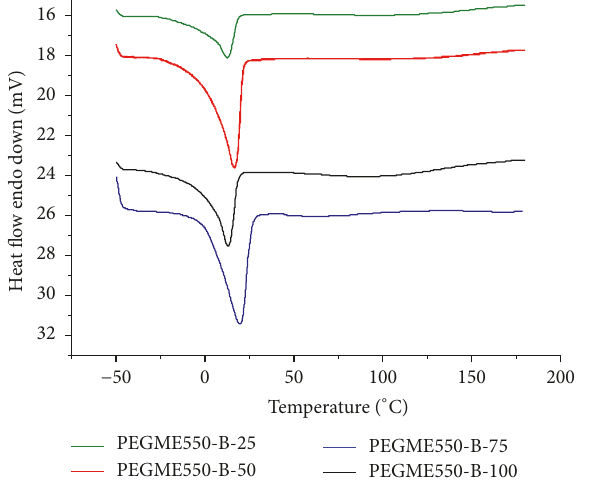
Figure 5: DSC curves of PEGME550-B- 𝑌 ( 𝑌 = 25, 50, 75, and 100) polymer electrolytes. Second heating run endotherms are presented at a heating rate of 10 ∘ C/min.